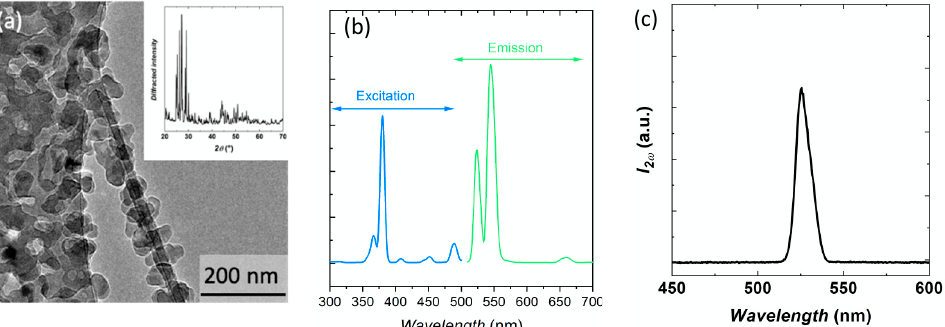
Figure 1. ( a ) Low-temperature TEM image of Yb 3+ ,Er 3+ -doped α -La(IO 3 ) 3 nanocrystals. The inset shows the powder X-ray diffraction pattern associated with these nanocrystals. ( b ) Room-temperature PL and PL excitation spectra of Yb 3+ ,Er 3+ -doped α -La(IO 3 ) 3 nanocrystals. The PL spectrum was recorded under a 380 nm excitation, whereas the PL excitation was recorded while monitoring the emission at 545 nm spectrum. ( c ) Second harmonic scattering signal from Yb 3+ ,Er 3+ -doped α -La(IO 3 ) 3 nanocrystals in ethylene glycol under a 1064-nm excitation.